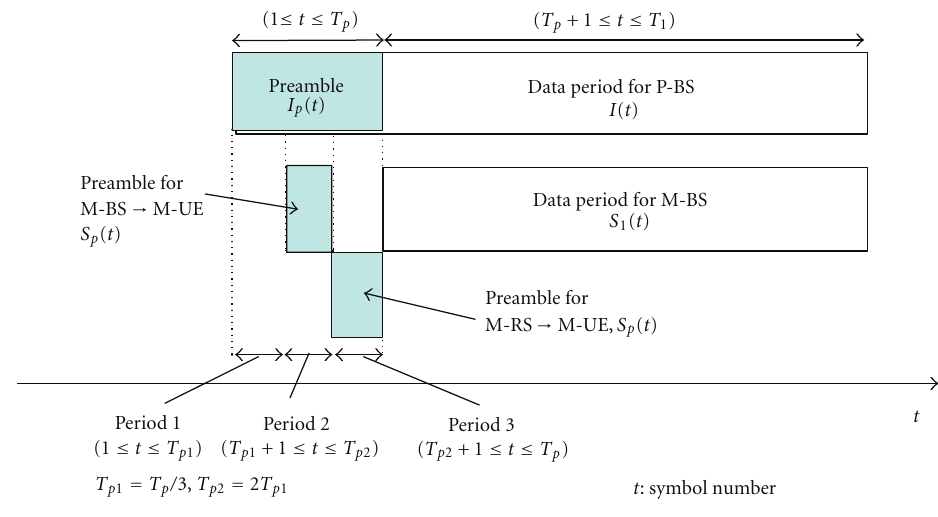
Figure 4: Transmit timing of preamble signals for CSI